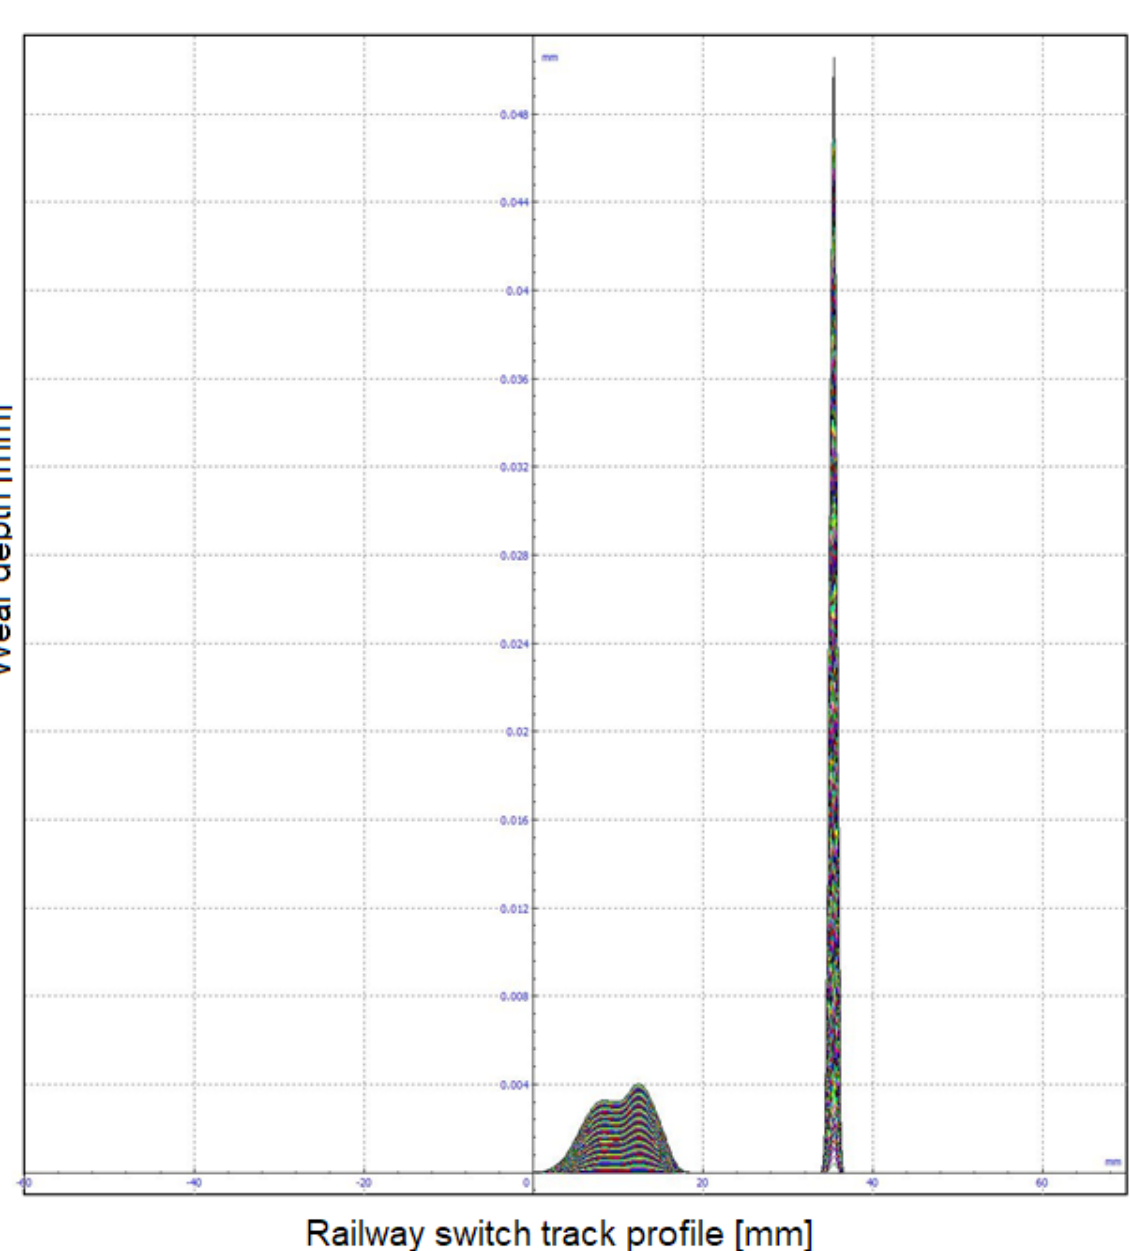
Figure 49. Rail wear for a straight track without a turnout with constant stiffness obtained at 350 km/h.